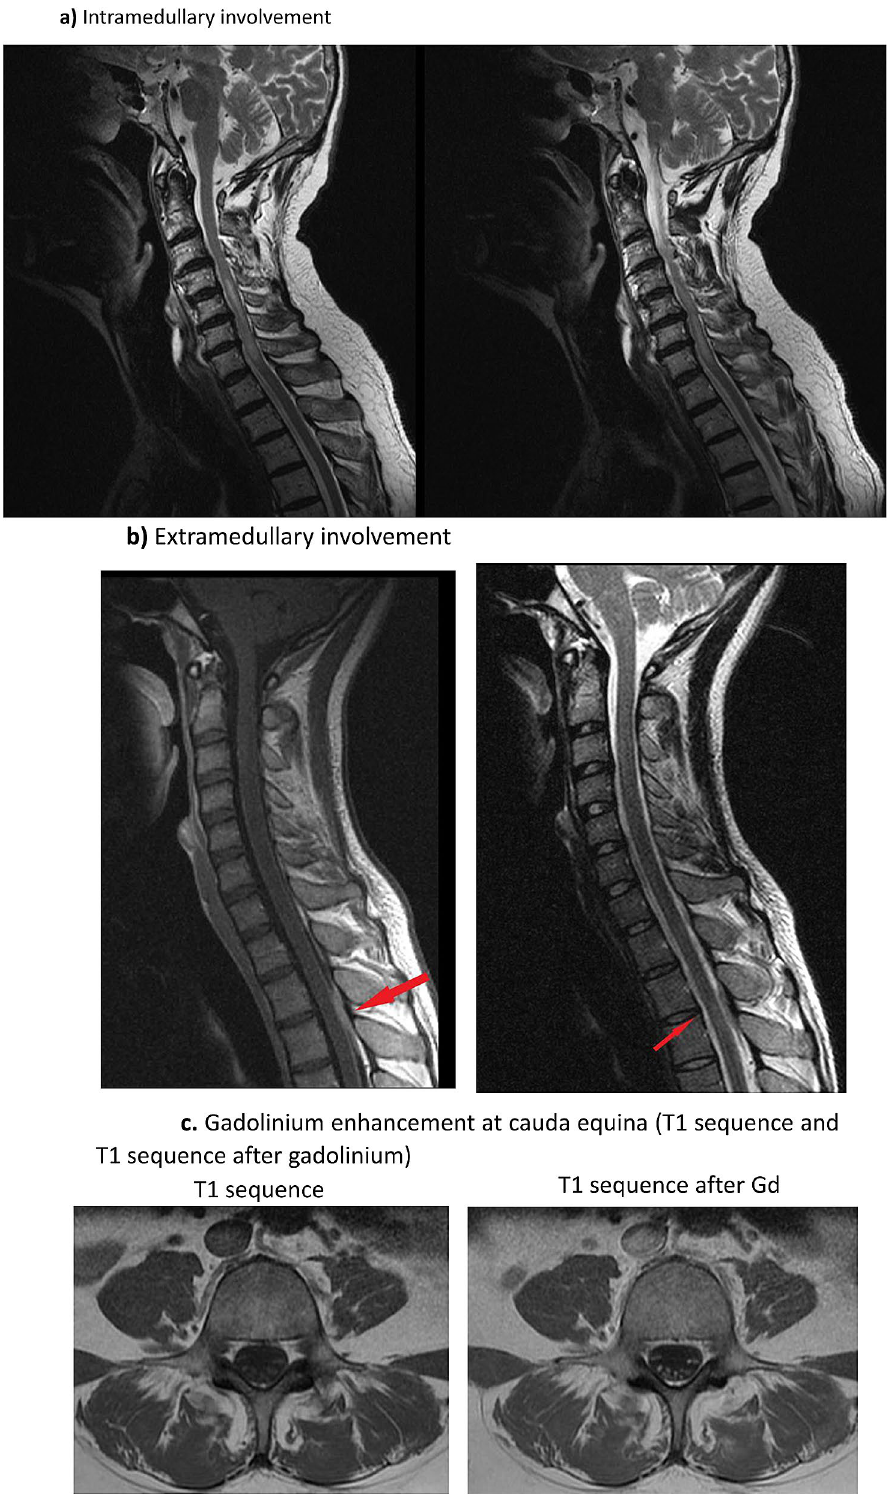
Figure 4. Medullary involvement: ( a ) Intramedullary involvement; ( b ) Extramedullary involvement; ( c ) Gadolinium enhancement at cauda equina (T1 sequence and T1 sequence after